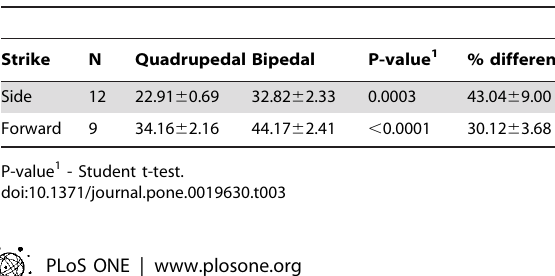
Table 3. Mean values and standard errors of force impulse (Ns) delivered during side and forward strikes from ‘‘quadrupedal’’ and bipedal posture.